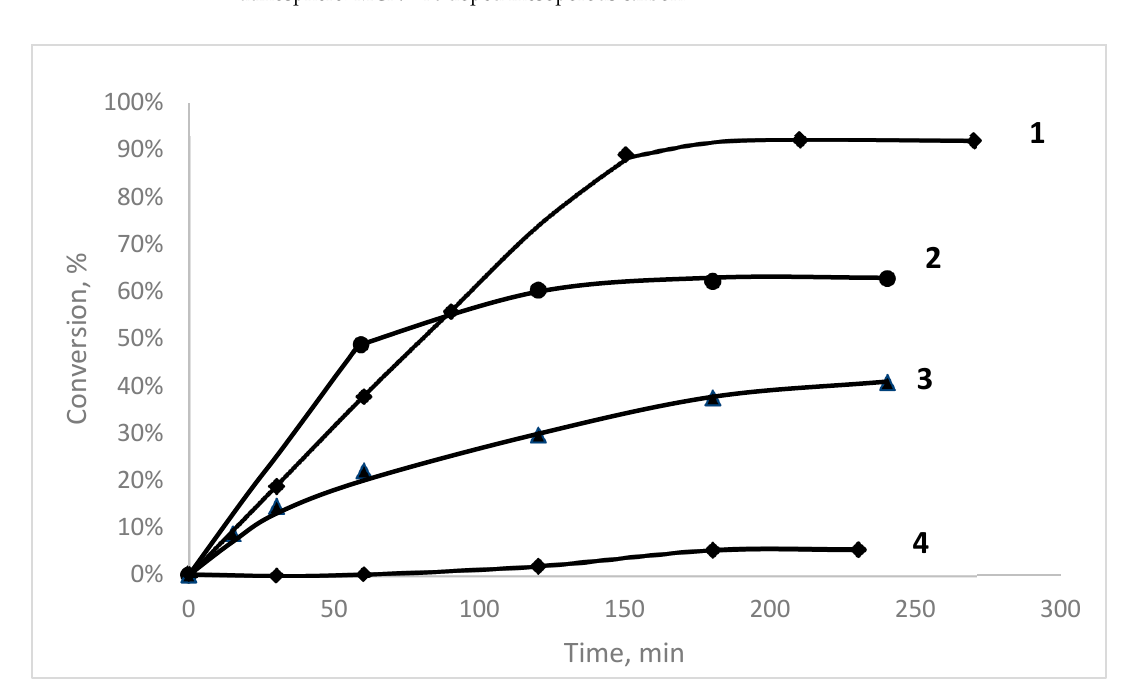
Figure 10. Hydroamination of phenylacetylene with aniline over synthesized nanocatalysts. Phenylacetylene: aniline molar ratio is 1:2. 1 . Au@meso-UiO-66 nanocatalyst; without solvent. 2 . Au@meso- NH 2 -UiO-66 nanocatalyst; without solvent. 3 . Au@meso-NH 2 -UiO-66 nanocatalyst; toluene used